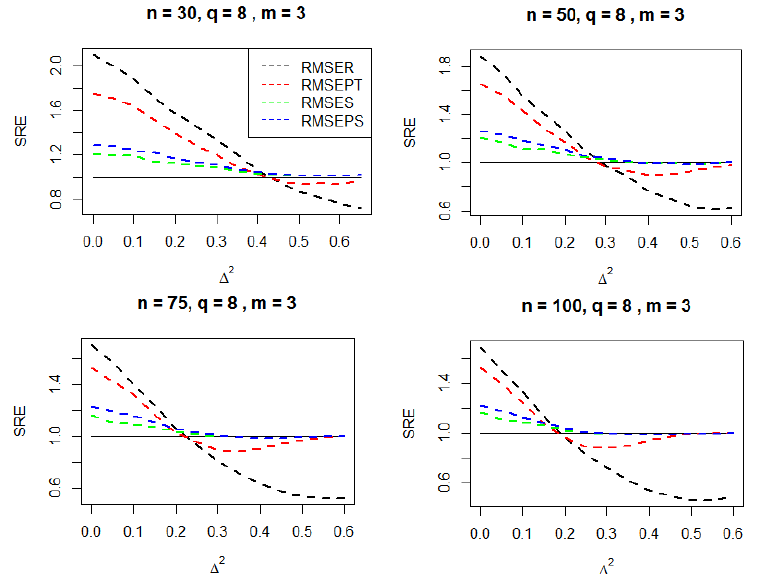
Figure 1. SRE of the restricted, pretest and shrinkage estimators with respect to ˆ θ U when ( m , q ) = ( 3,8 ) and for different sample